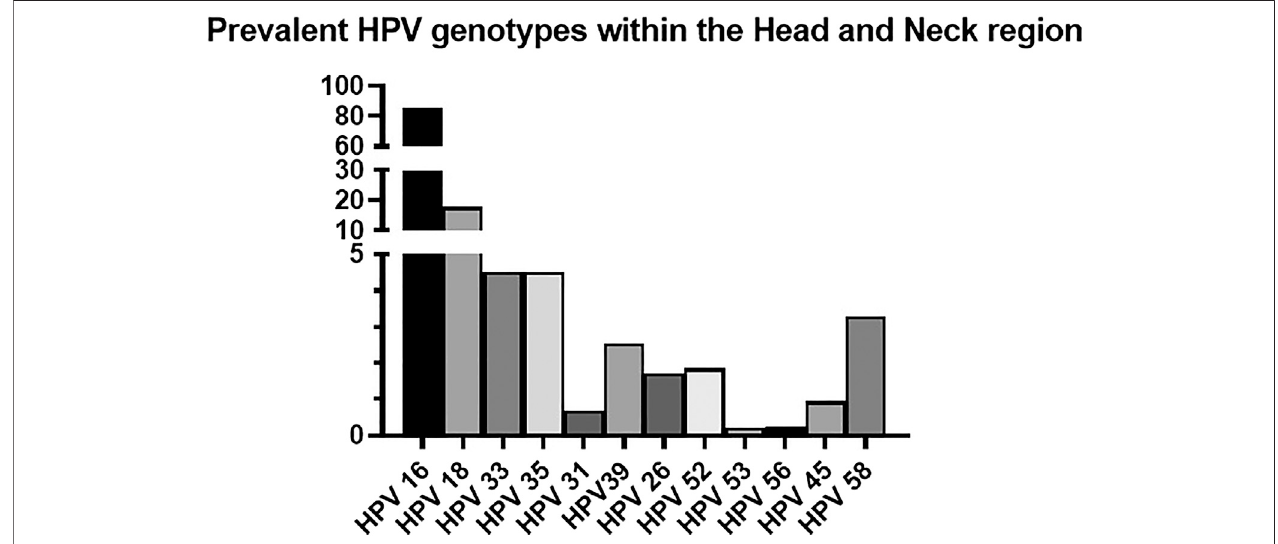
FIGURE2| PrevalentHPV genotypeswithintheHeadand Neckregion(Goodman et al.,1990;Koskinenet al.,2003; Kreimer et al.,2005; Chaturvediet al., 2008; Evans and Powell, 2010; Deng et al., 2012; Dufour et al., 2012; Boscolo-Rizzo et al., 2013; Ndiaye et al., 2014; Castellsagué et al., 2016; de Martel et al., 2017; Ursu et al., 2018; Gillison et al., 2019a; Tumban, 2019; Kim et al.,